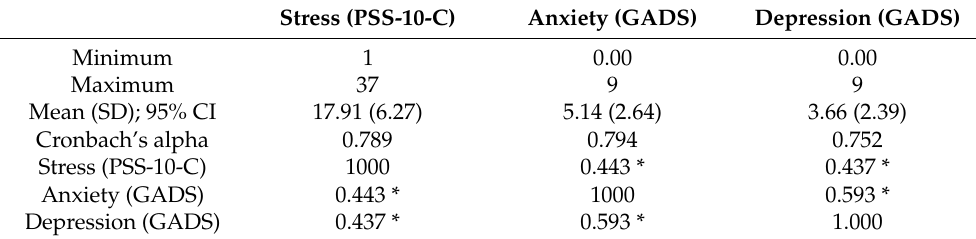
Table 2. Characteristics of the study population’s stress and anxiety/depression.